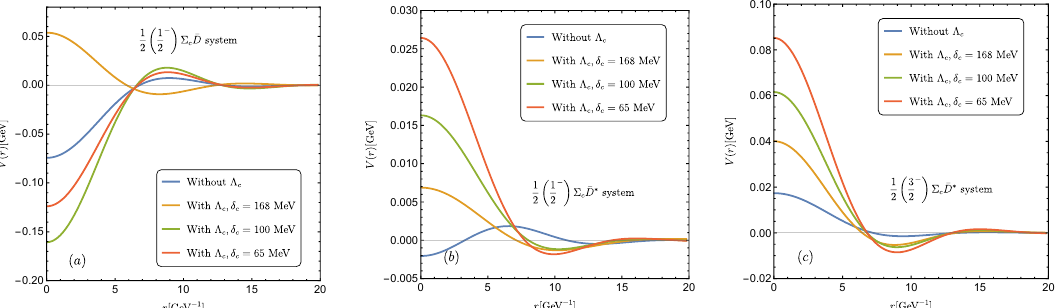
Figure 11 . The variations of the two-pion-exchange potentials for the (cid:6) c (cid:22) D ( (cid:3) ) systems in the cases of without and with the (cid:3) c . Their I ( J P ) are marked in each sub(cid:12)gure. The dependence on the mass splitting (cid:14) c is also